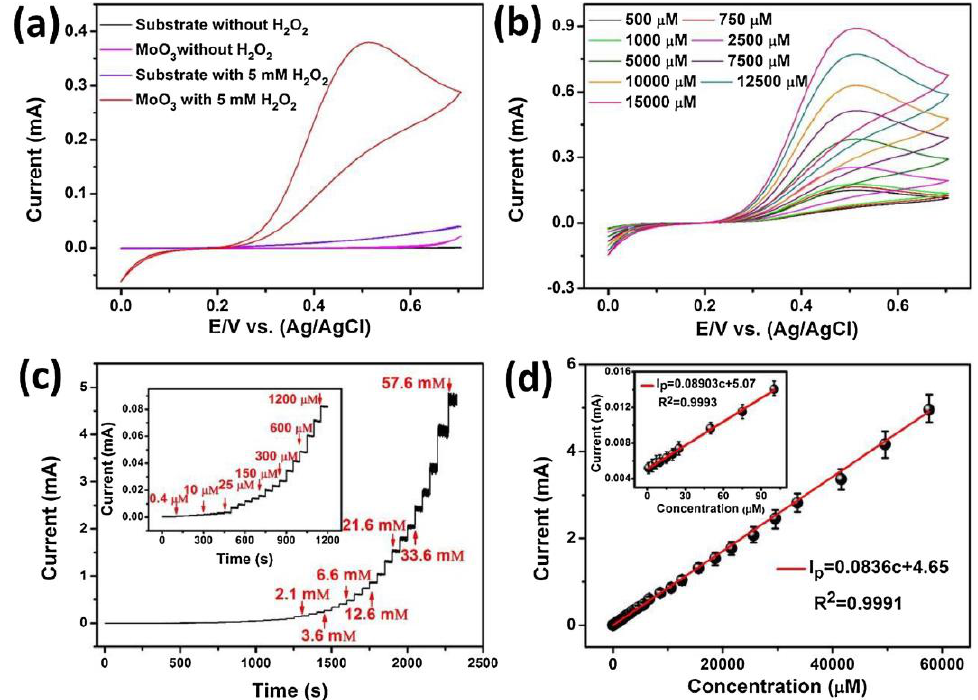
Figure 6. ( a ) Cyclic voltammetry (CV) of the bare substrate and atomic layer deposition (ALD)-developed 2D α-MoO 3 in the absence and presence of 5 mM H 2 O 2 . ( b ) CV curves of 2D α-MoO 3 at different concentration of H 2 O 2 . ( c ) Amperometric current response to H 2 O 2 concentration variation. ( d ) Current vs. H 2 O 2 concentration. Reprinted with permission from reference [64].